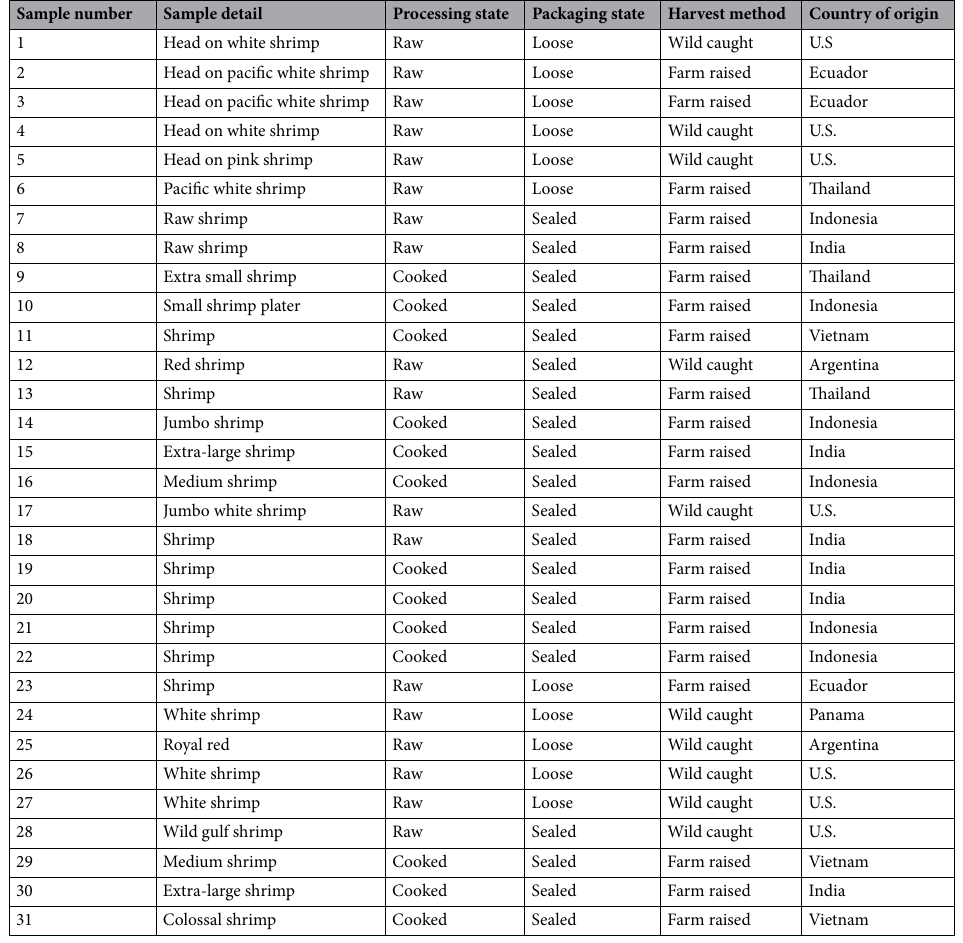
Table 1. Shrimp sample details for ABR study collected from Florida and